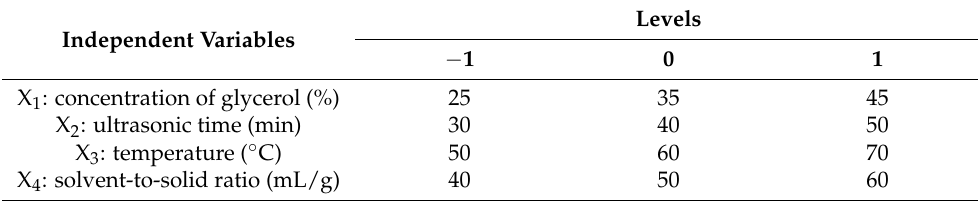
Table 1. The variables levels for the experimental design Independent Variables